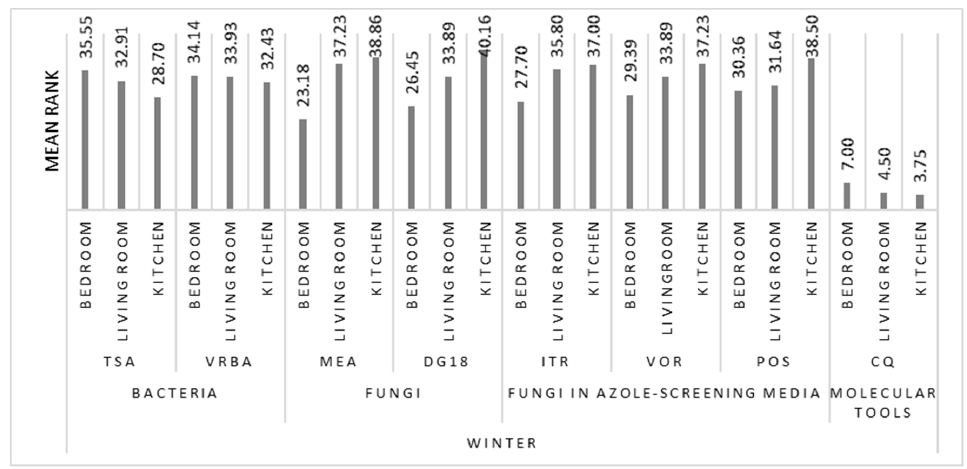
Figure 5. Results of the Kruskal-Wallis multiple comparisons of bacterial and fungal counts, azole, and Cq in the three sampling locations (bedroom, living room, and kitchen), in winter. Among the three types of geographical location of the houses (urban, rural, or suburban), no statistically significant differences were detected, either in summer or in winter, in relation to dust loadings, bacterial counts (TSA and VRBA), fungal counts (MEA and DG18), and azole resistance screening (ITR, VOR, and POS) ( p ’s > 0.05). The comparison between seasons displayed statistically significant differences with higher values in winter for: (i) Bacterial counts on TSA (z = − 6.624, p = 0.000), (ii) bacterial counts on VRBA (z = − 2.761, p = 0.005), (iii) fungal counts on MEA, and (iv) fungal counts on DG18 (Table 11). Table 11. Comparison between summer and winter for dust loads, bacterial and fungal counts, and azole screening resistance.